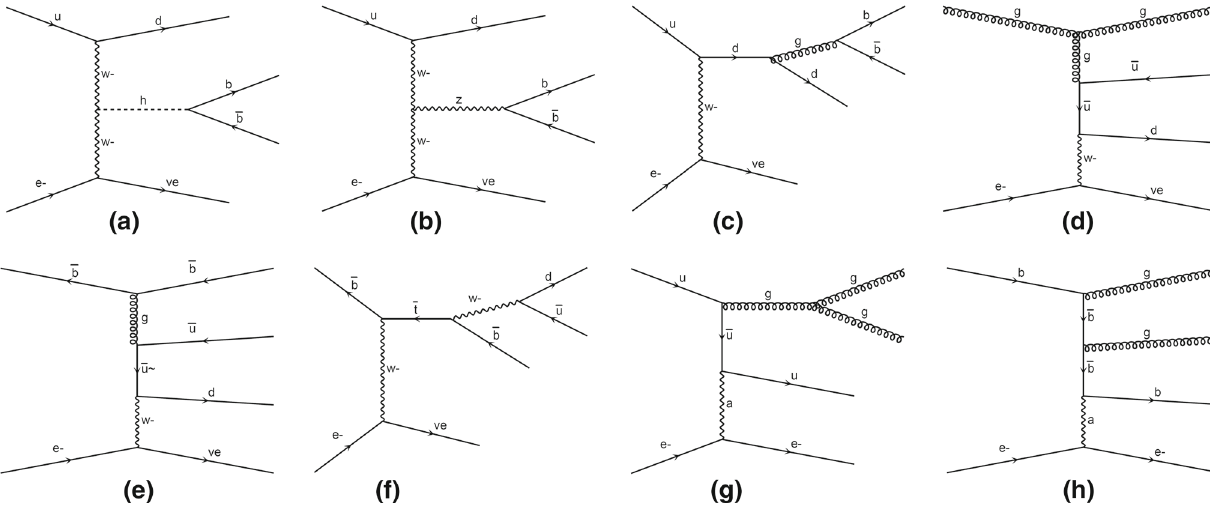
Fig. 2 Some examples of partonic Feynman diagrams for the reducible and irreducible backgrounds correspond to the